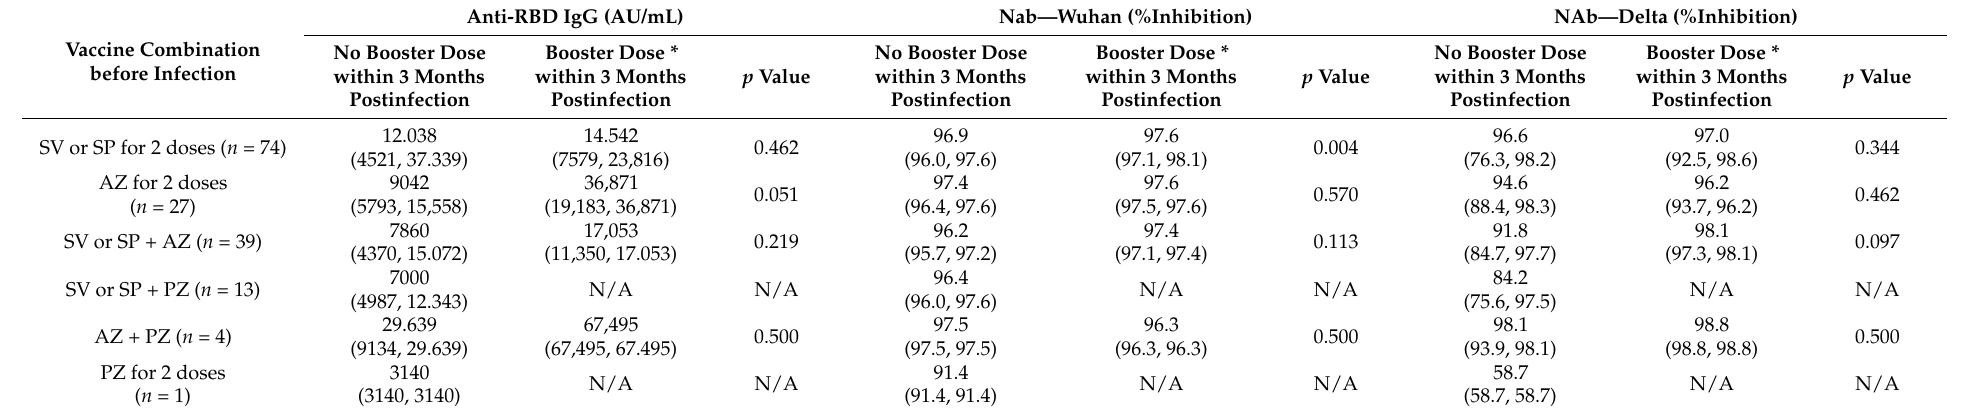
Table 3. Antibody levels of anti-RBD IgG and NAb against Wuhan and Delta strains at 3 months after SARS-CoV-2 infection in fully vaccinated participants; n = 158. All antibody levels are presented as median (interquartile